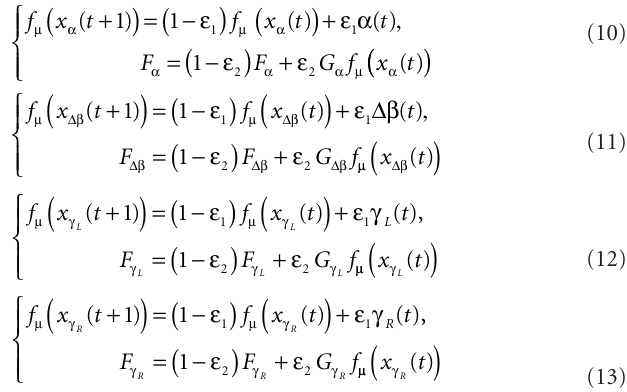
FIGURE 7 | Sensorimotor information fl ow for γ 50 trials for each values. (A) Plot of the average walking duration stability (in seconds) dependent to the coupling strength γ . Transfer entropy measure of resp.